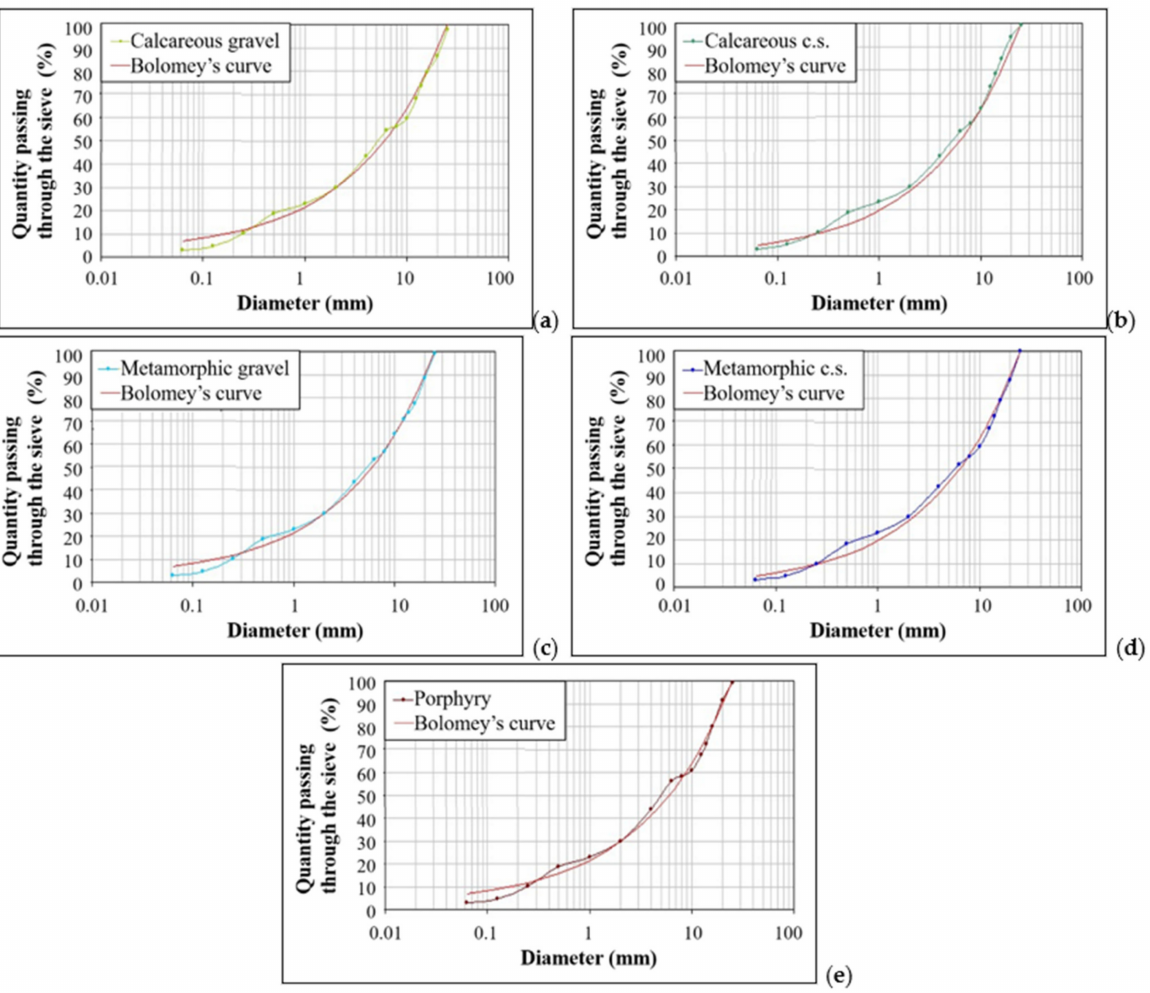
Figure 5. Grain size distributions of the five mixture samples analyzed following the Bolomey’s curve: ( a ) aggregate mixture with calcareous gravel (Table 1); ( b ) aggregate mixture with calcareous crushed stone (Table 2) (c.s. in the graph means crushed stone); ( c ) aggregate mixture with metamorphic gravel (Table 3); ( d ) aggregate mixture with metamorphic crushed stone (Table 4) (c.s. in the graph means crushed stone); ( e ) aggregate mixture with porphyry (Table